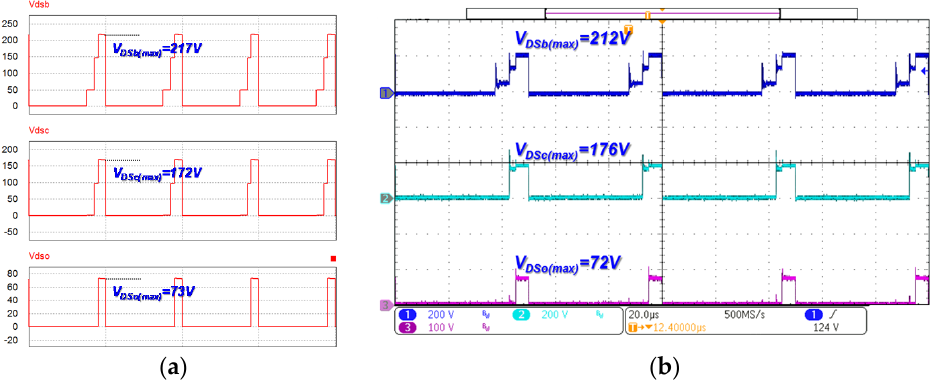
Figure 12. Gate driving signal and battery current waveforms in the battery charging mode: ( a ) by simulation; and ( b ) by measurement.